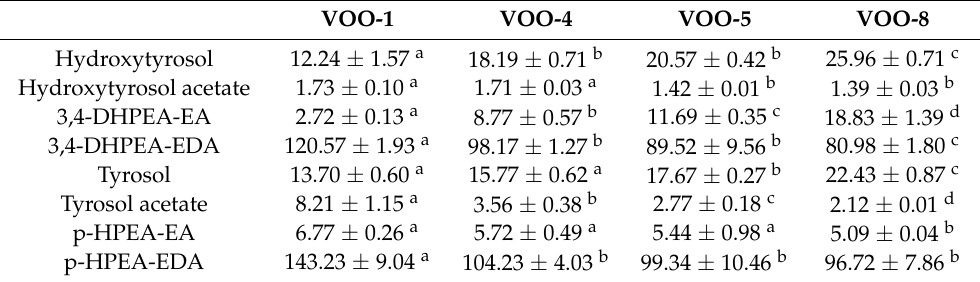
Table 3. Concentrations (mg/kg) of oleuropein and ligstroside derivatives (mean ± SD) of the control samples in four months of the storage process.